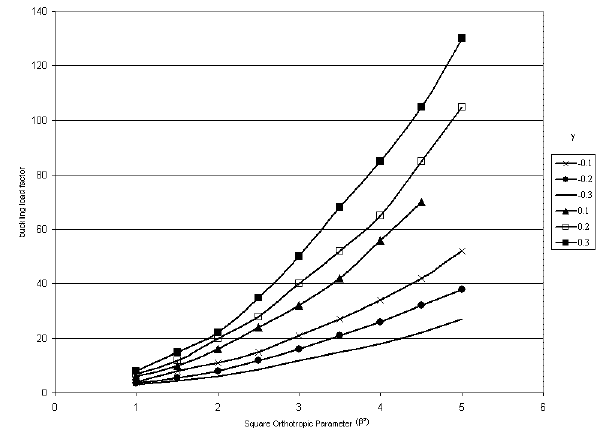
Fig. 3. Variation of buckling load factor respect to orthotro- pic parameter and non-dimensional geometric parameter with simply supported outer edge